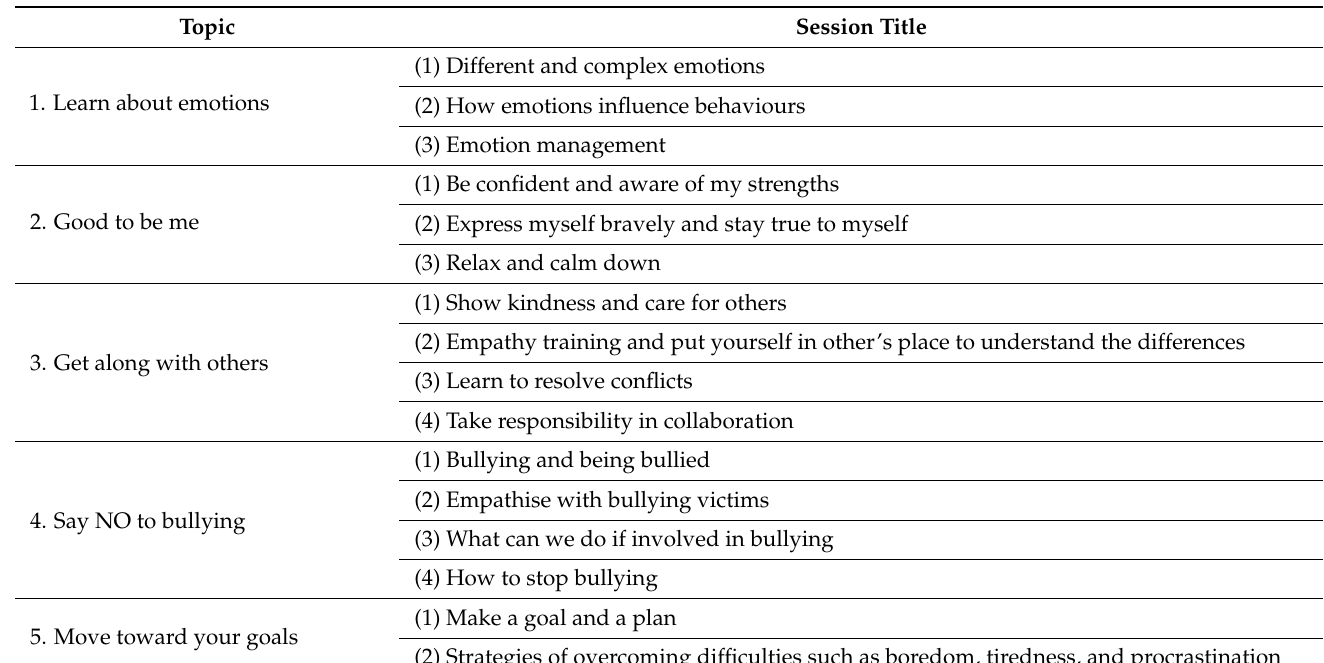
Table 1. Content of the intervention